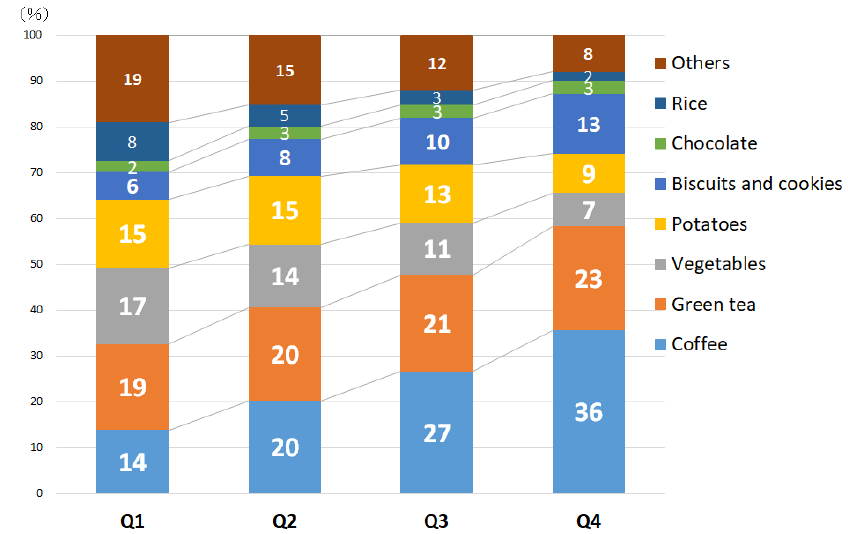
Figure 3. Comparison of the percentage contribution of acrylamide-containing foods to dietary acrylamide intake among quartiles of acrylamide intake.